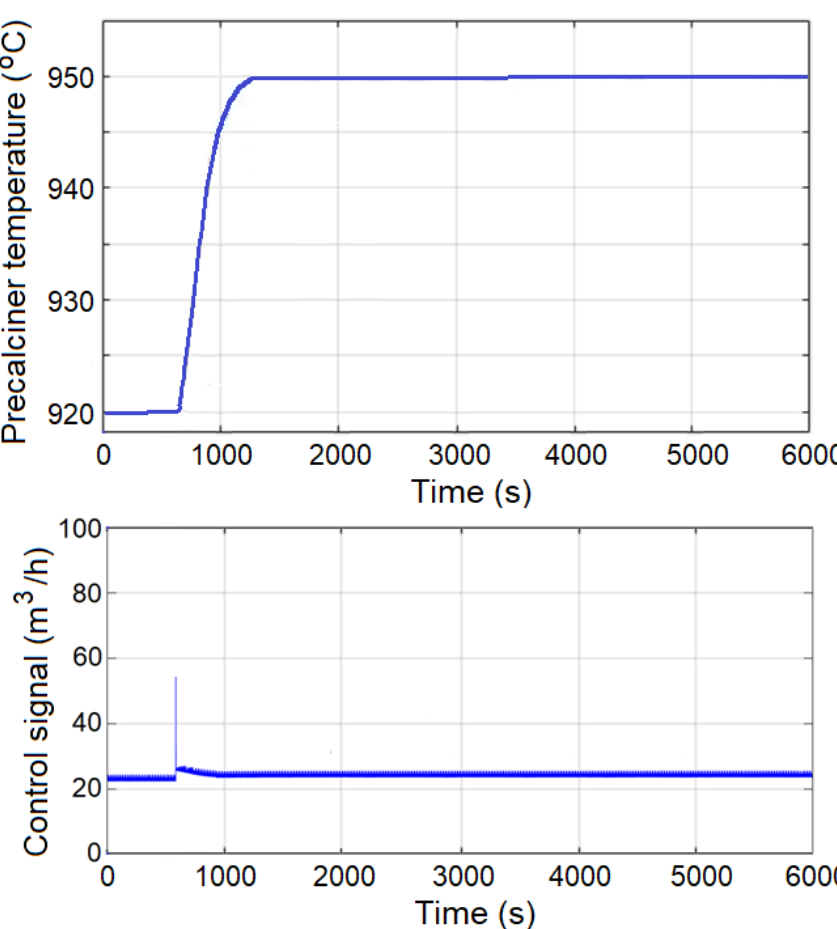
Figure 6. Time response of the control system with the DTC-H ∞ -SFC controller designed, as well as the control effort against a change in the command signal from 920 to 950 °C.